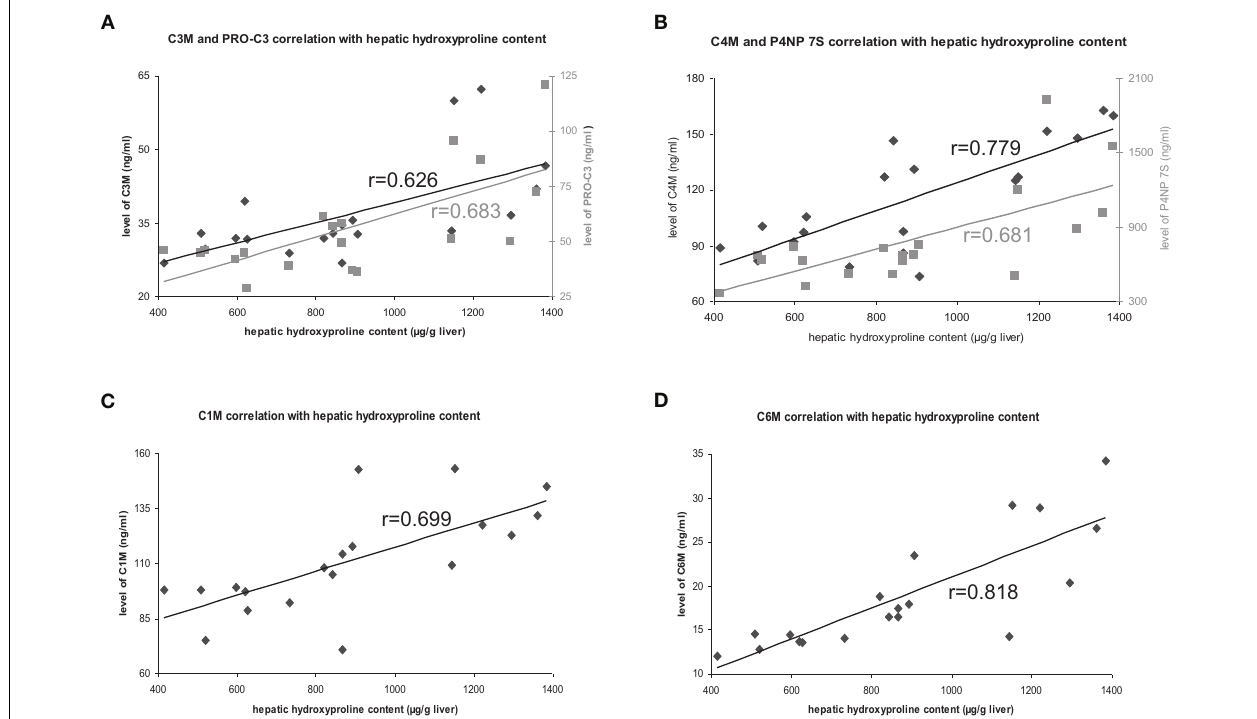
FIGURE 2 | Correlation of hepatic hydroxyproline content with ECM markers. Correlations with degradation markers shown in black, correlations with formation markers shown in gray.